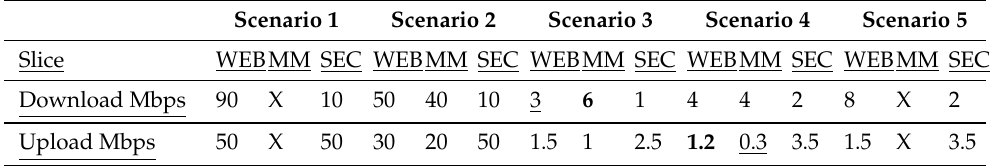
Table 4. Calculation of max-rates in different